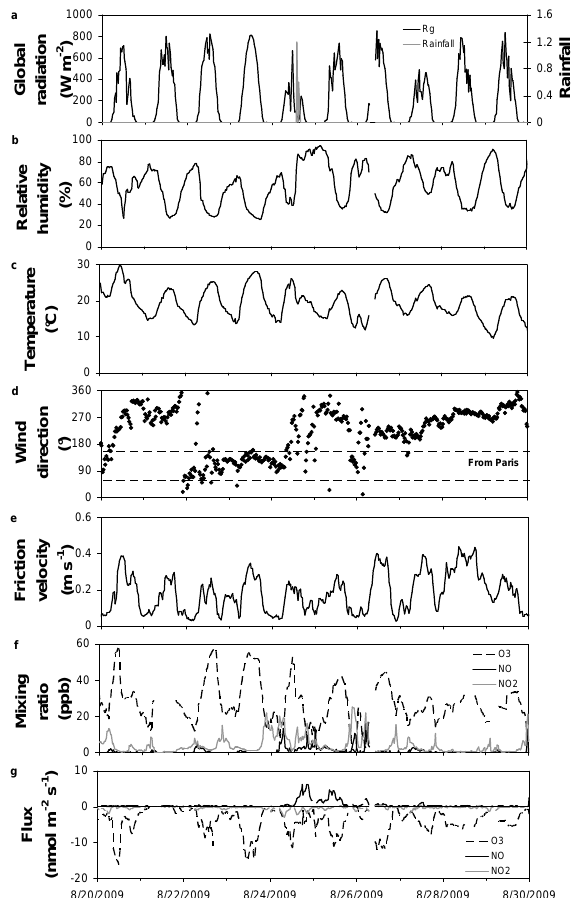
Figure 2: Time series of (a) global radiation (black line) and rainfall (grey line), (b) air relative humidity, (c) air temperature, (d) wind direction, (e) friction velocity, (f) O 3 (dotted line), NO (black line) and NO 2 (grey line) mixing ratios, and (g). O 3 (dotted line), NO (black line) and NO 2 (grey line) fluxes without chemical corrections determined by the AGM at z = 0.61 m. The fluxes were calculated without chemical corrections and tests on quality assurance. The dotted lines in panel (d) indicate winds coming from Paris.